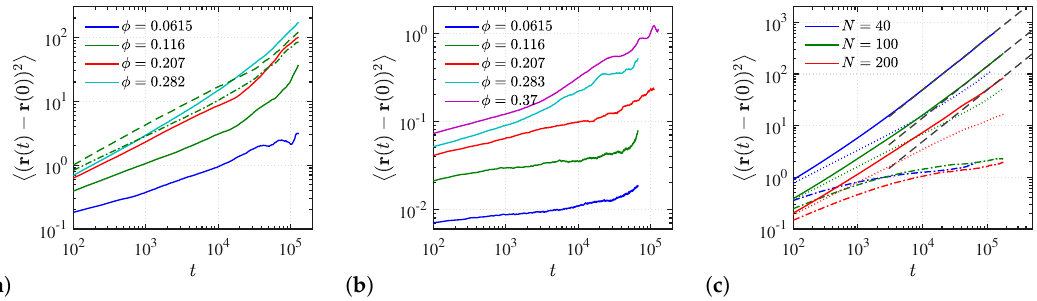
Figure 8. Mean-squared displacement (MSD) of NPs for with ( a ) end-charged and ( b ) p3-charged N = 40 chains for dispersed systems at different NP volume fractions. Dashed and dash-dotted lines in ( a ) show the MSD for systems with NP loading of φ = 11.6% of end-charged chains with polymerization degrees N = 200 and N = 100, respectively. ( c ) MSD of polymer center-of-mass for NP loading of φ ≈ 37% (solid lines), φ = 20.8% (dotted lines), and φ = 11.6% (dash-dotted lines) for p3-charged chains. Dashed black lines in ( c ) indicate the diffusion limit where MSD ( t ) ∝ t